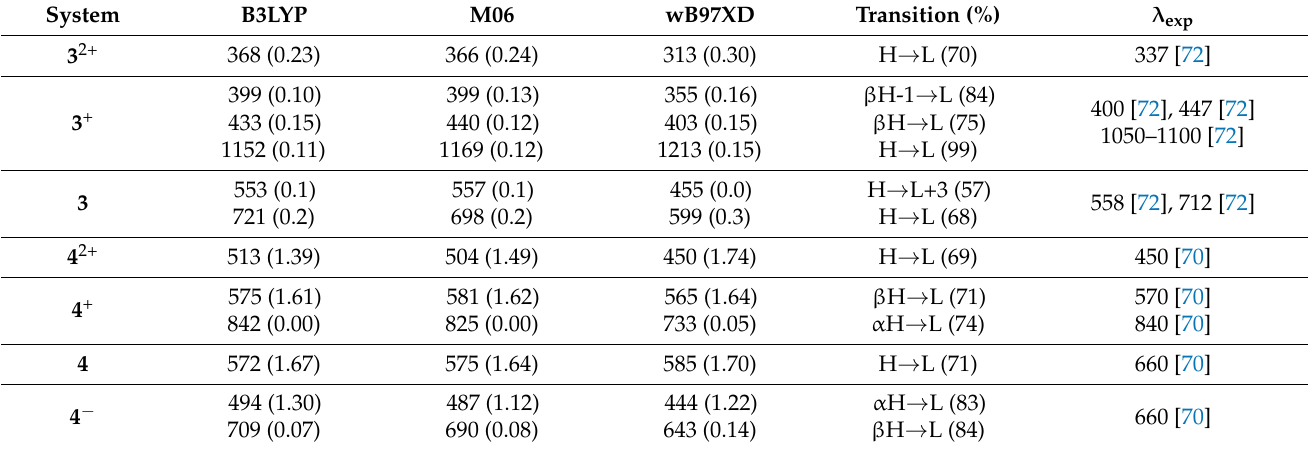
Table 2. Excitation energies (nm) and oscillator strength of three and four molecules in different oxidation states computed in dichlorometane solvent by using different exchange-correlation potentials and the 6–31+G* basis set. The % of the transition is that obtained at the B3LYP level. Experimental data are taken from refs